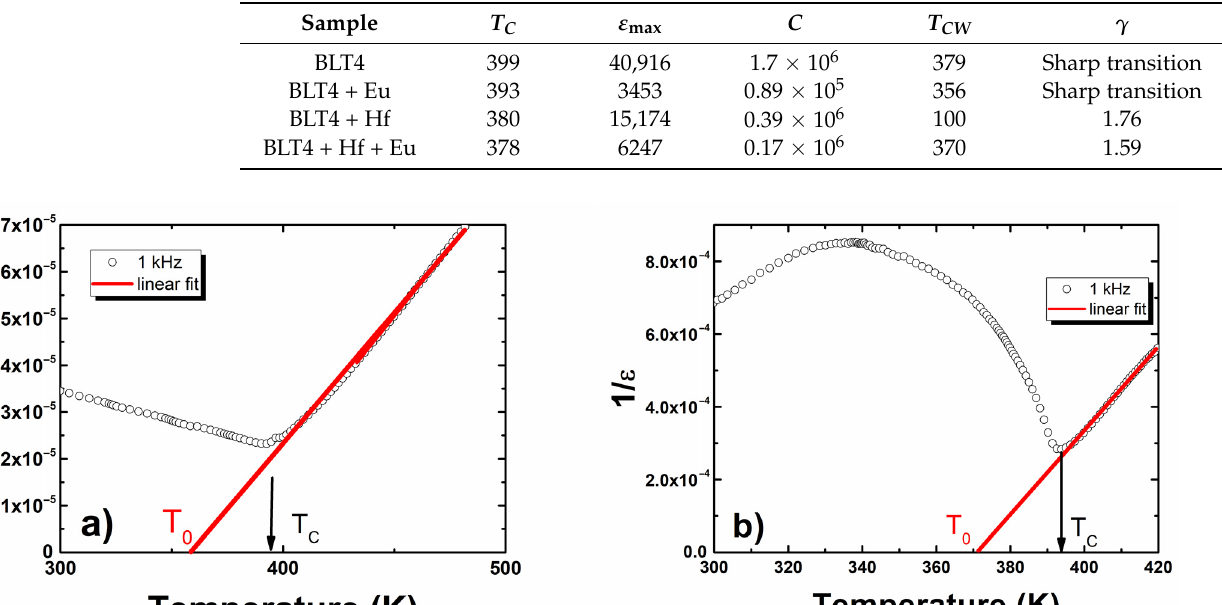
Table 5. Influence of the modificators on the dielectric parameters of BLT4 ceramics: Tc—Curie tem- perature, ε max —maximum value of dielectric permittivity at Tc, C—Curie constant, T CW —Curie– Weiss temperature, and γ —diffuseness parameter.